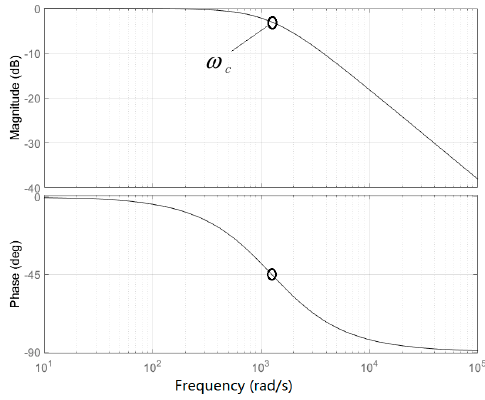
Figure 13. Bode diagram of the current regulator.